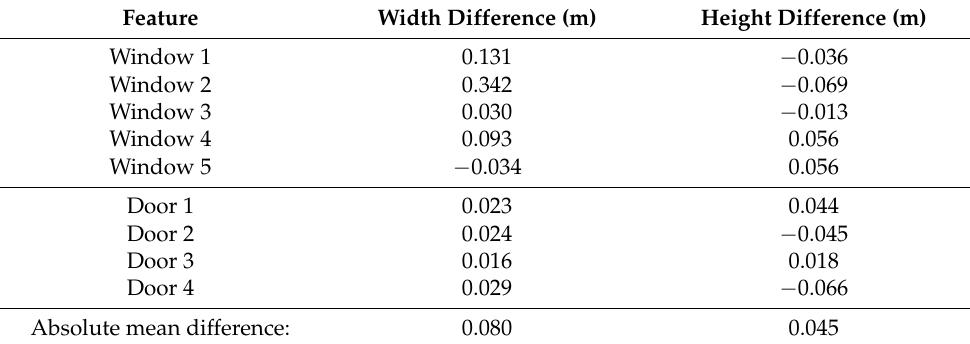
Table 3. Door and window dimensions for the Signal